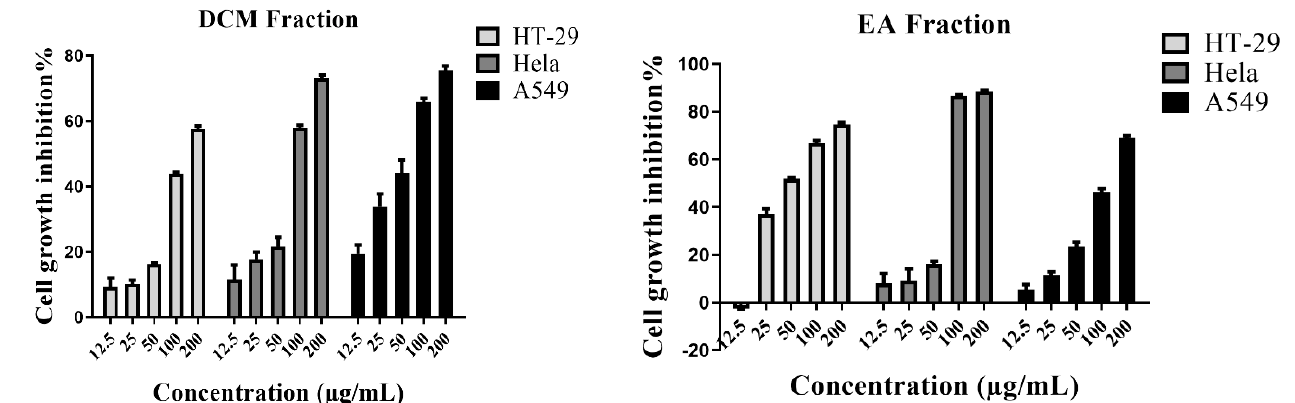
Figure 3. Antiproliferative activity in inhibition rate (%) at different concentrations of DCM (dichloromethane) and EA (ethyl acetate) fractions, respectively, against cancer cell lines HT-29, Hela, and A549 by the MTT assay. The cell growth inhibition rate of the ethanol extract, petroleum ether, and n-butanol could be expressed at a higher concentration than 200 µg/mL. The solvent’s inhibition rate was near zero value on all the cell lines. The data were expressed as mean ± SD ( n = 3). Table 2. IC 50 values of DCM and EA fractions on HT-29, HeLa, and A549. Fraction